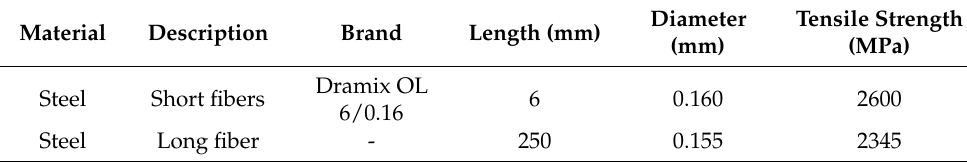
Table 2. Properties of the high-strength short steel fibers.